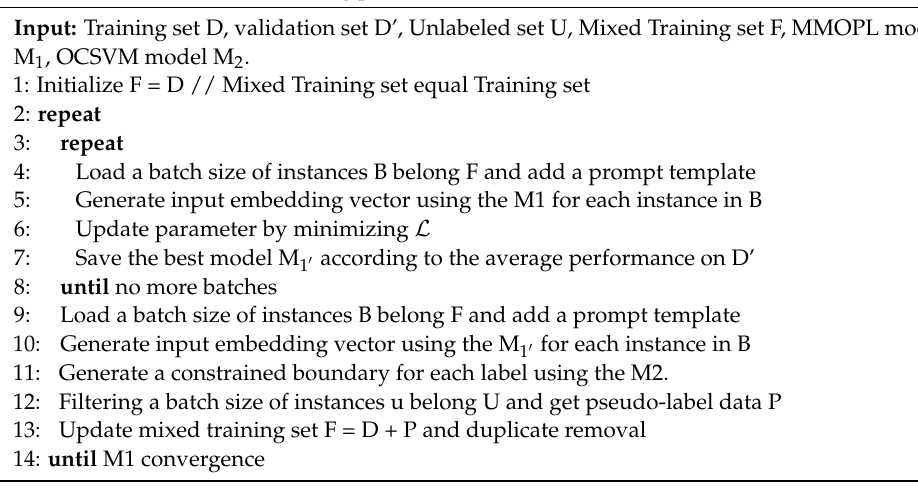
Algorithm 1 The iterative training process of the